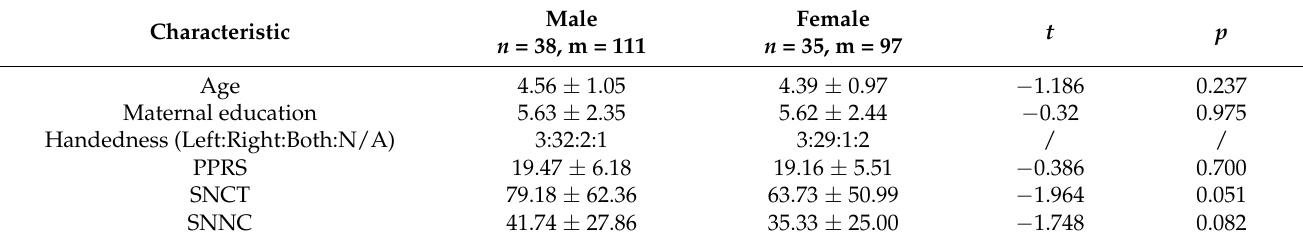
Table 1. Demographics and Clinical Measures of